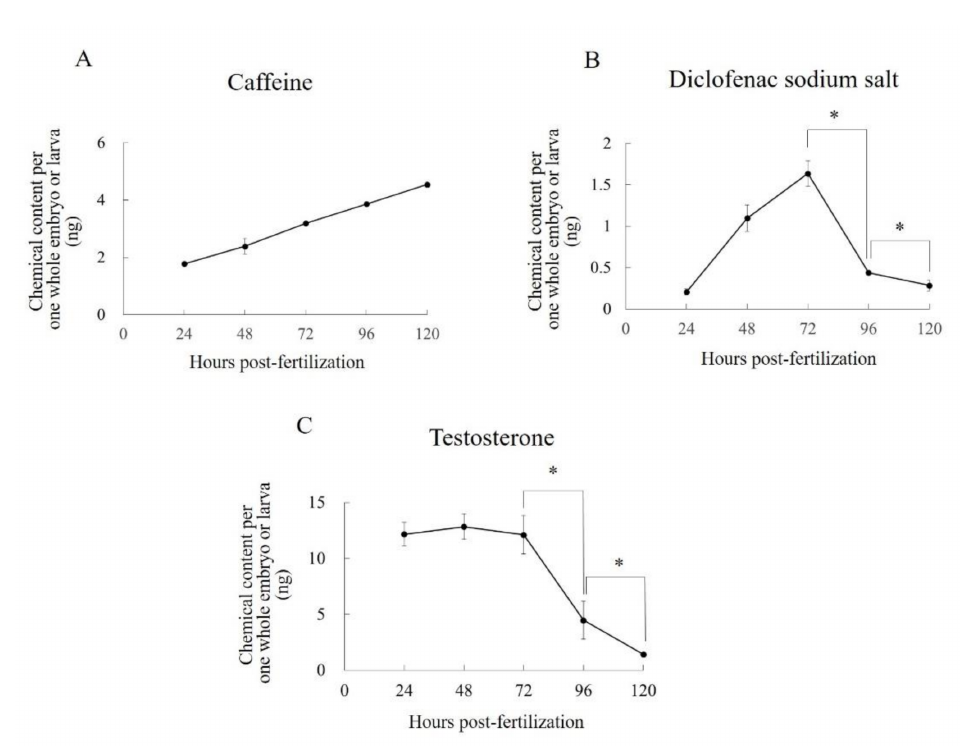
Figure 5. Contents of ( A ) ca ff eine, ( B ) diclofenac sodium salt, and ( C ) testosterone per one whole embryo / larva during exposure to each test compound. Each plot shows the mean values of three replicates. Each error bar shows the standard deviation of the replicates. Significant di ff erences between two specific data points, as determined by a two-tailed t -test, are shown by an asterisk ( p < 0.05). Statistical analyses were performed only for the specific sets of data points shown by the